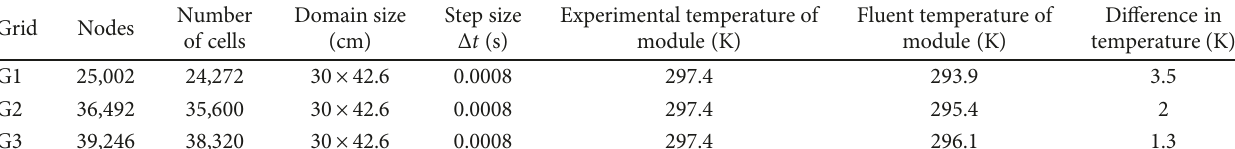
Table 3: Details of meshes tested in grid independence.